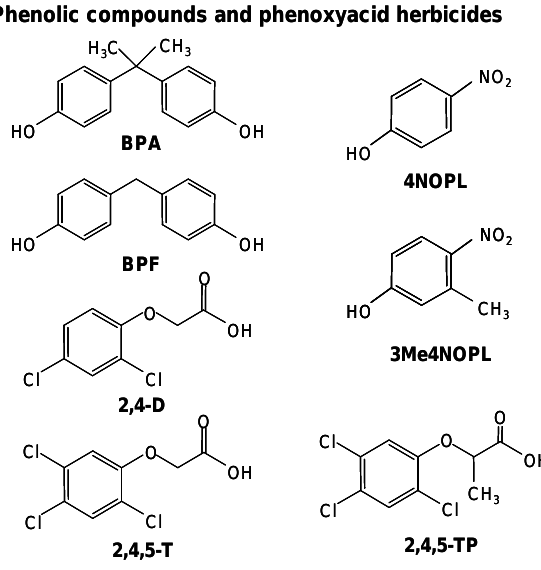
Figure 1. Chemical structures of all the compounds